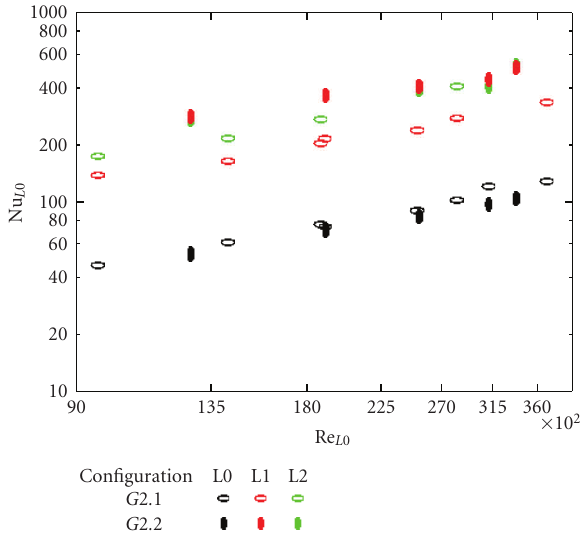
Figure 8: G 2.1 and G 2.2 data—Nu L 0 versus Re L 0